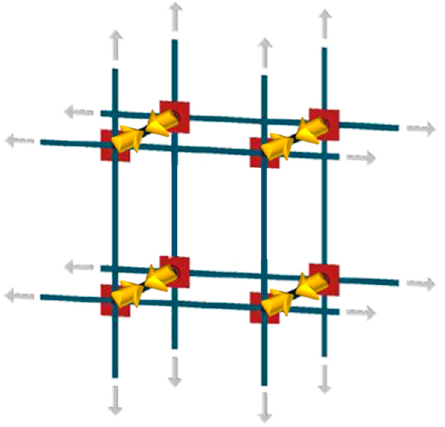
Figure 3. Nodal forces transferred by the CAM straps: Balanced forces in gray and not balanced forces in yellow [1].